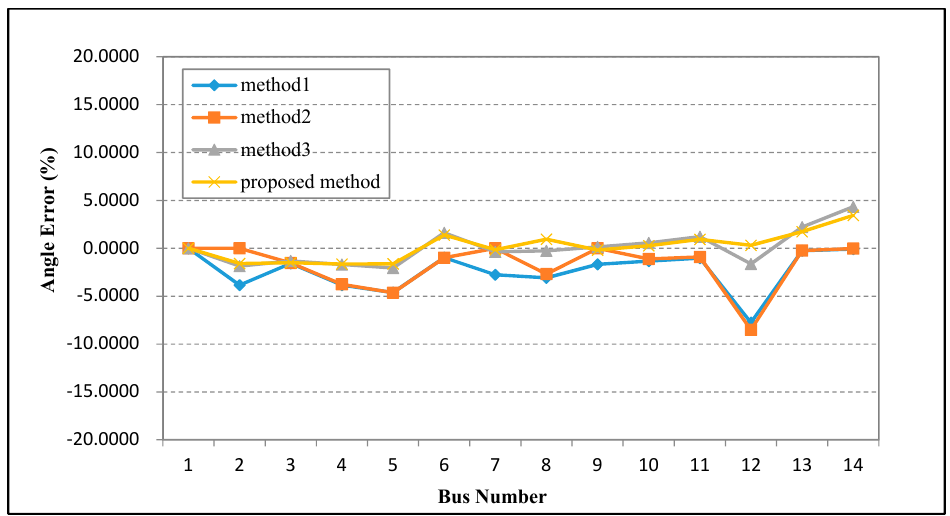
Figure 10. The percentage of bus voltage angle estimate error in 14 bus system.